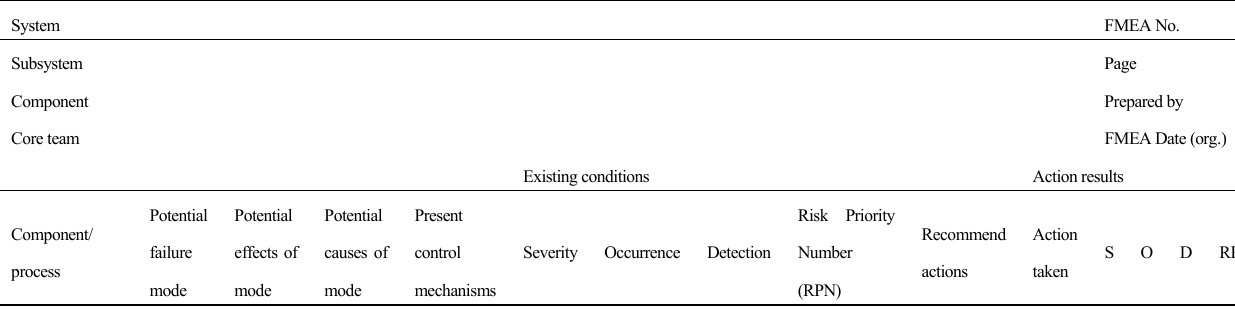
Table 1. Format of an FMEA report [10].